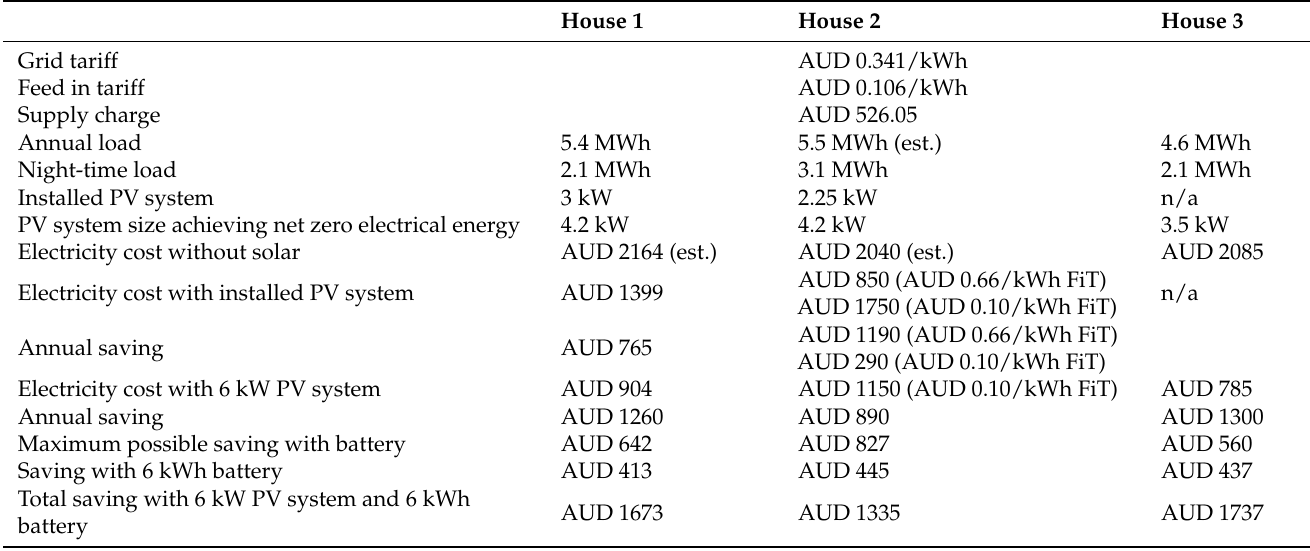
Table 6. Comparison of the three houses (2018